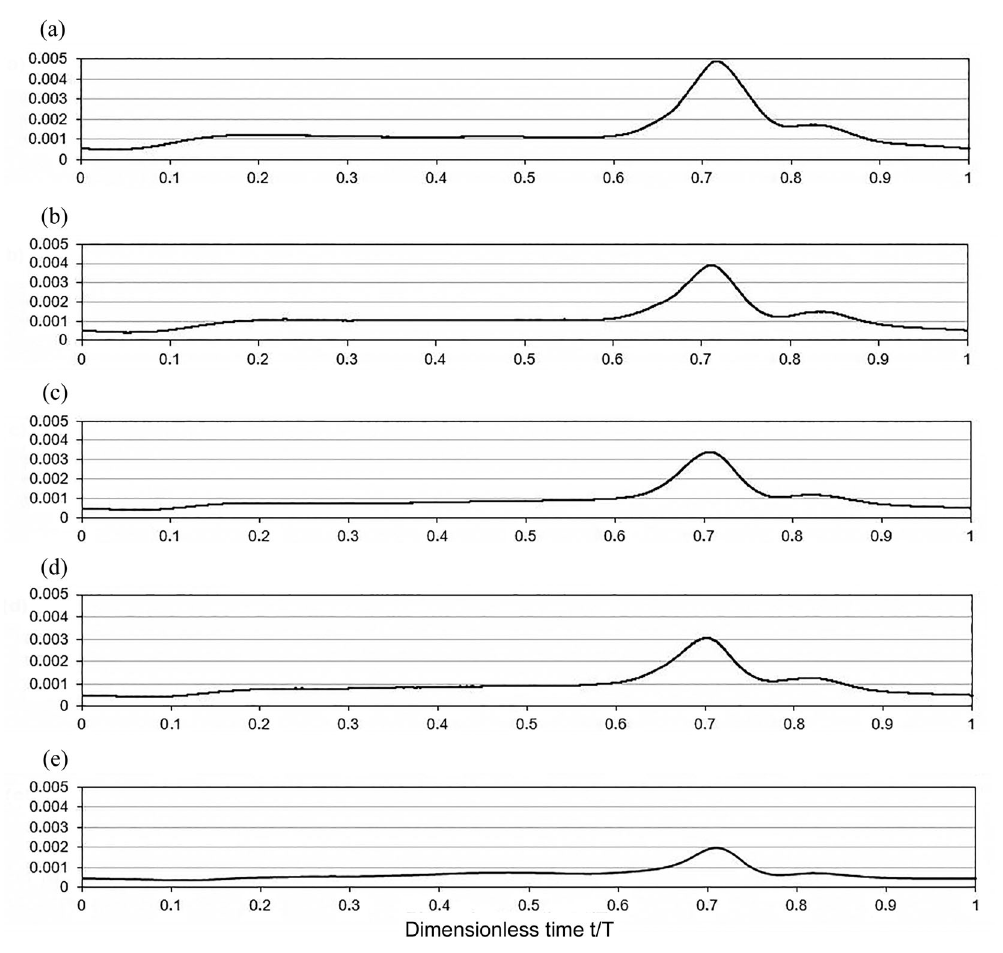
Fig. 4. Measured turbulent kinetic energy at different heights above sloping bottom: a) 0.067 m; b) 0.052 m; c) 0.040 m; d) 0.028 m and e) 0.006